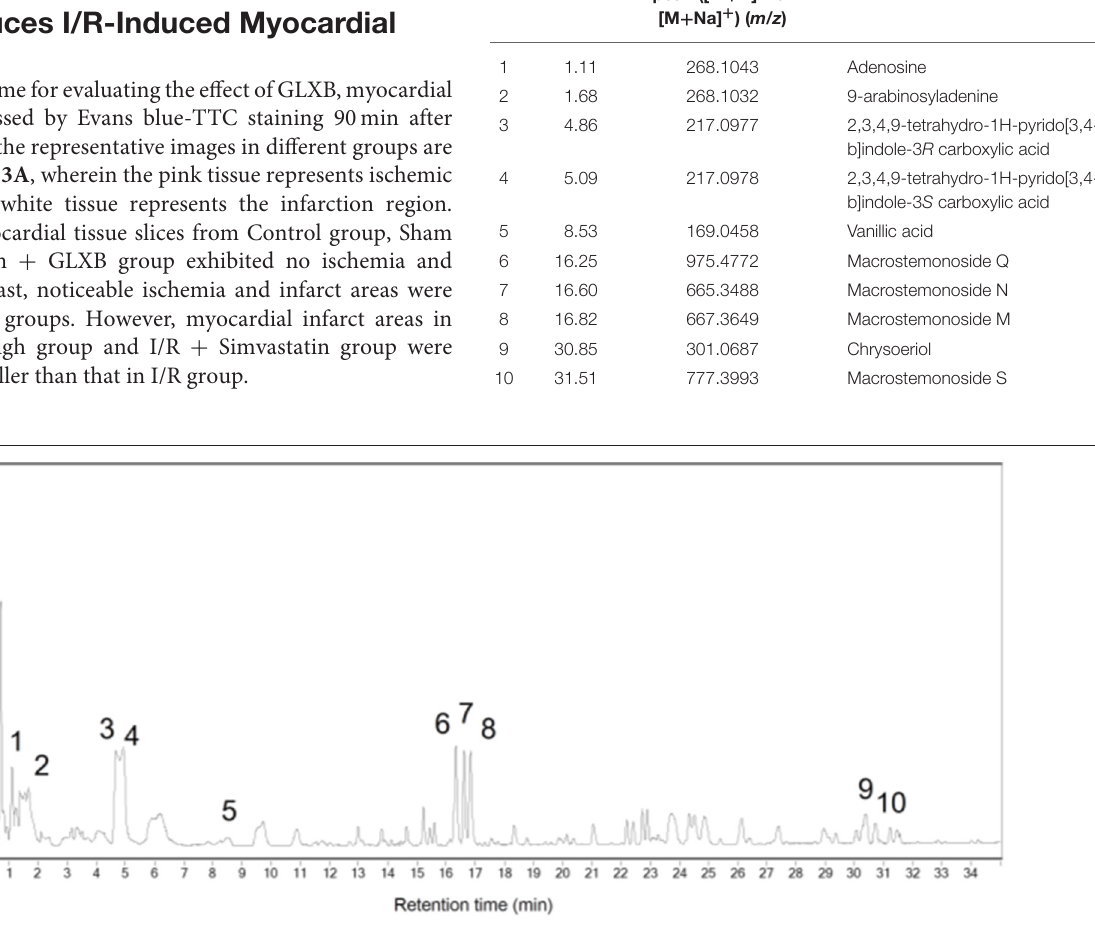
Frontiers in Physiology |